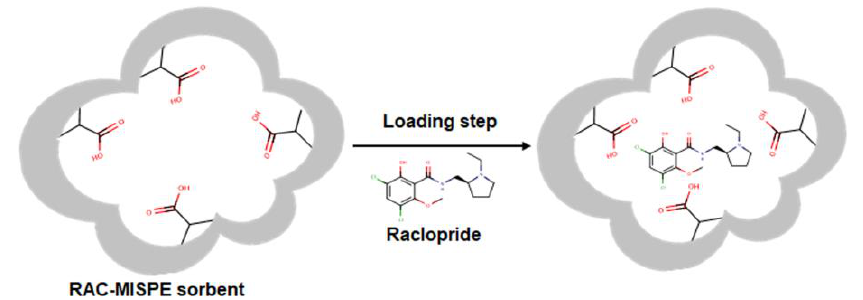
Figure 6. Schematic representation of interaction between RAC and RAC-MISPE sorbent.